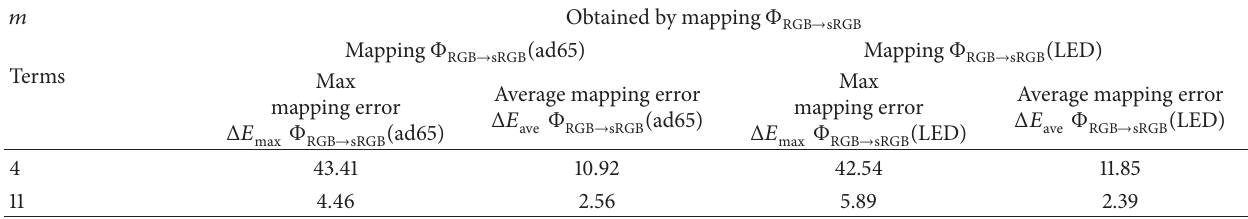
Table 2: The accuracy comparison Δ𝐸 𝑖 ( Φ RGB → sRGB ) in sRGB color space obtained by mapping coefficient matrix Φ RGB → sRGB . 𝑚